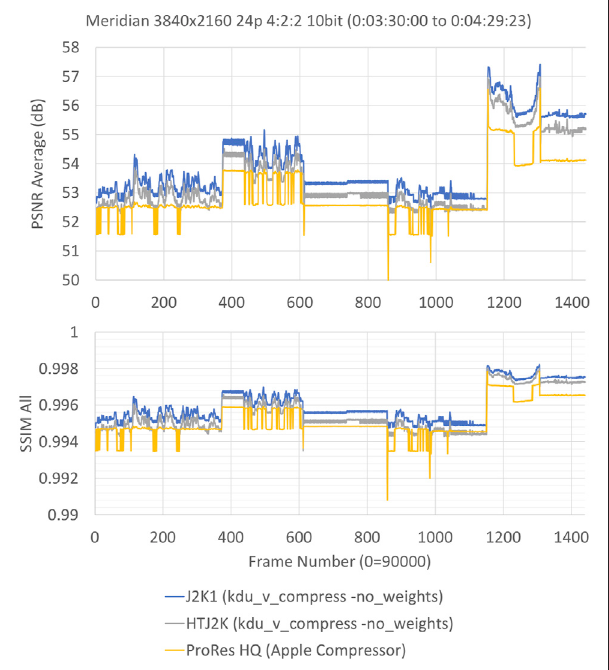
FIGURE 10 | PSNR and SSIM performance.